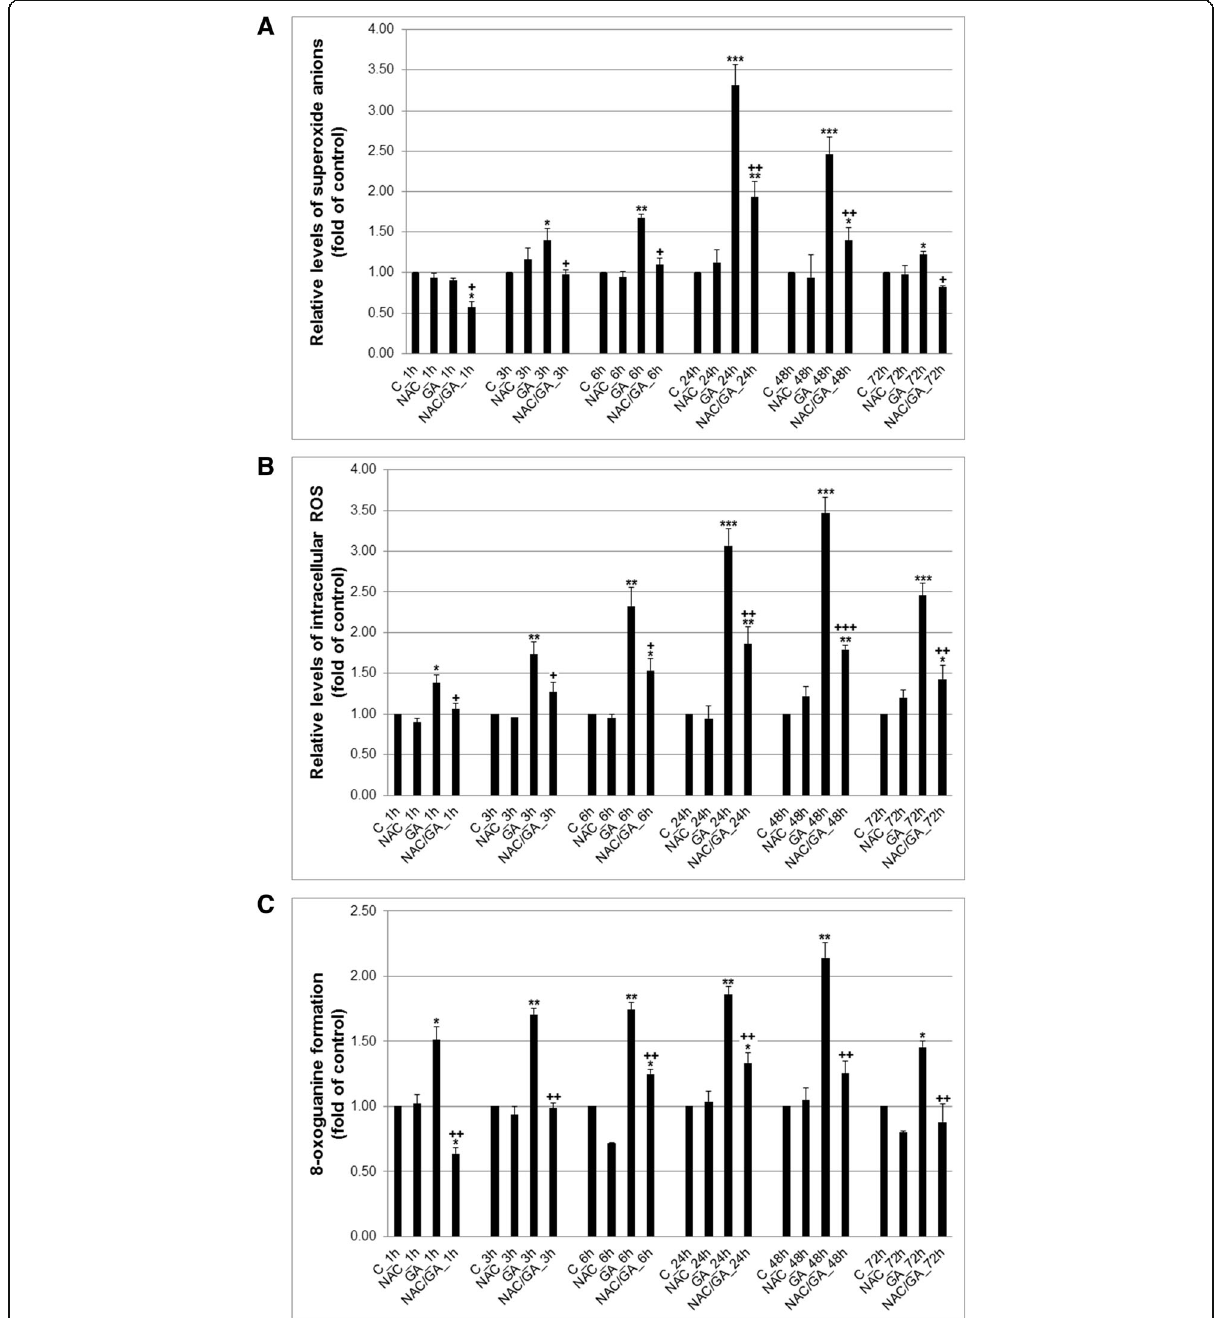
Fig. 2 Effect of GA alone or after NAC pre-treatment on superoxide anion generation ( a ), ROS levels ( b ) and DNA damage induction ( c ) in HeLa cells. Data were obtained from three independent flow cytometry experiments after 1 – 72 h GA treatment. Significance: * P < 0.05, ** P < 0.01, *** P < 0.001 versus untreated cells (control); + P < 0.05, ++ P < 0.01, +++ P < 0.001 versus